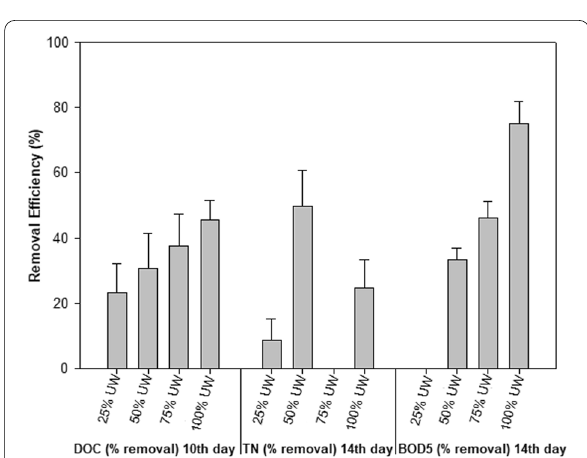
Fig. 4 Maximum removal efficiency (%) of DOC and TN on the 10th day and BOD 5 on the 14th day in the different treatments (25% UW, 50% UW, 75% UW, and 100% UW). Data are expressed as mean standard deviation (n ± =